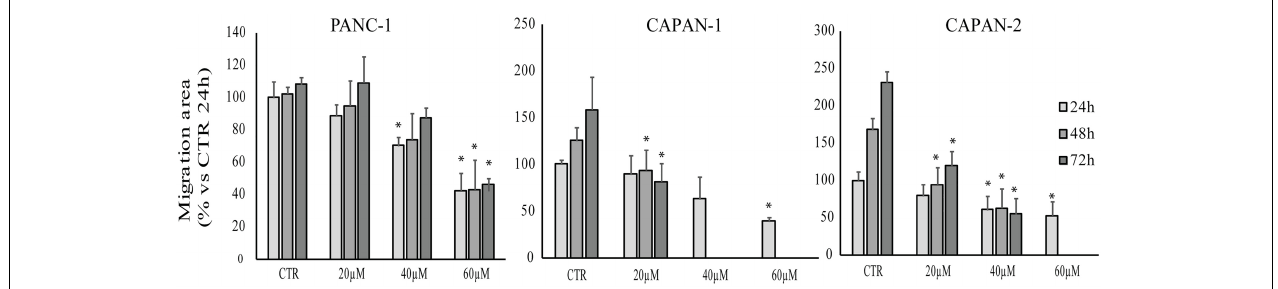
FIGURE 5 | Effect of RC-106 on Capan-1, Capan-2, and Panc-1 cell migration. Migration area of cells was quantified after 24, 48, and 72 h of treatment with increasing concentrations of RC-106 (20–60 µ M). Data are expressed as the average percentage ± SD of at least three independent experiments and are compared to controls (CTR, 100%; ∗ P < 0.05 vs. respective